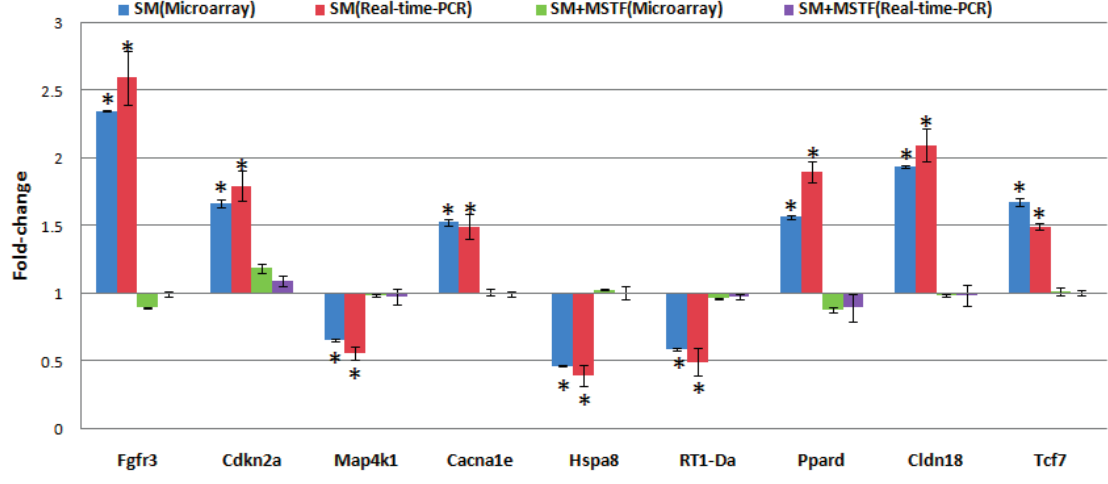
Figure 6. Quantitative real-time PCR confirmation of the microarray data. qRT-PCR was performed on nine genes that showed differential expression in treatment groups (SM, SM + MSTF) versus untreated controls. Gene expression levels are shown as the mean normalized to the expression of the housekeeping gene β -actin. Each sample was measured in triplicate. Columns, mean of three or four rats in the microarray experiment or a mean of five rats in PCR; bars, SD. Asterisks indicates statistical significance compared to the control (non-SM exposed rats) by the t -test ( p < 0.05). The comparison of the fold change produced by the microarray with the relative expression ratio obtained from real-time PCR, with good